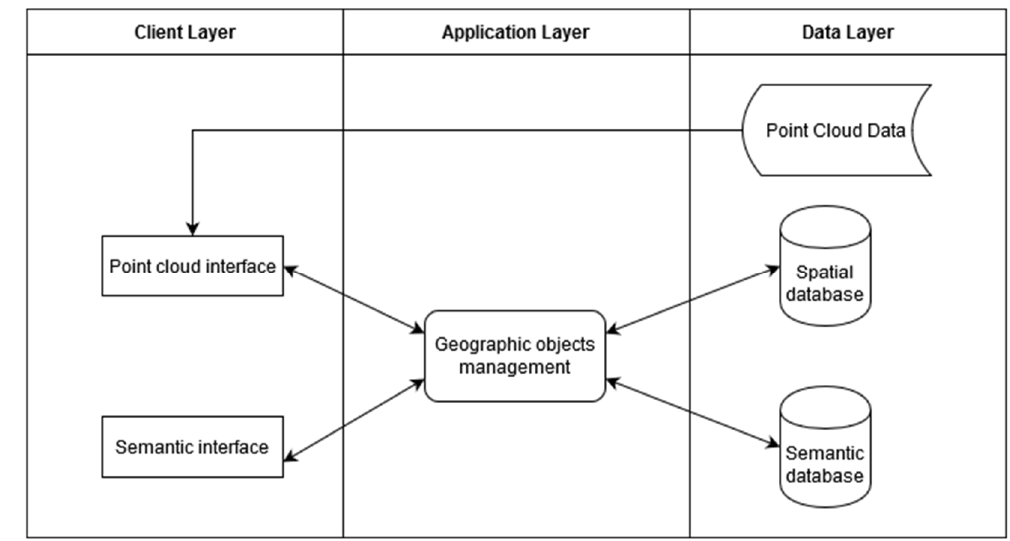
Figure 10. Architecture of the SIA (conceptual model).